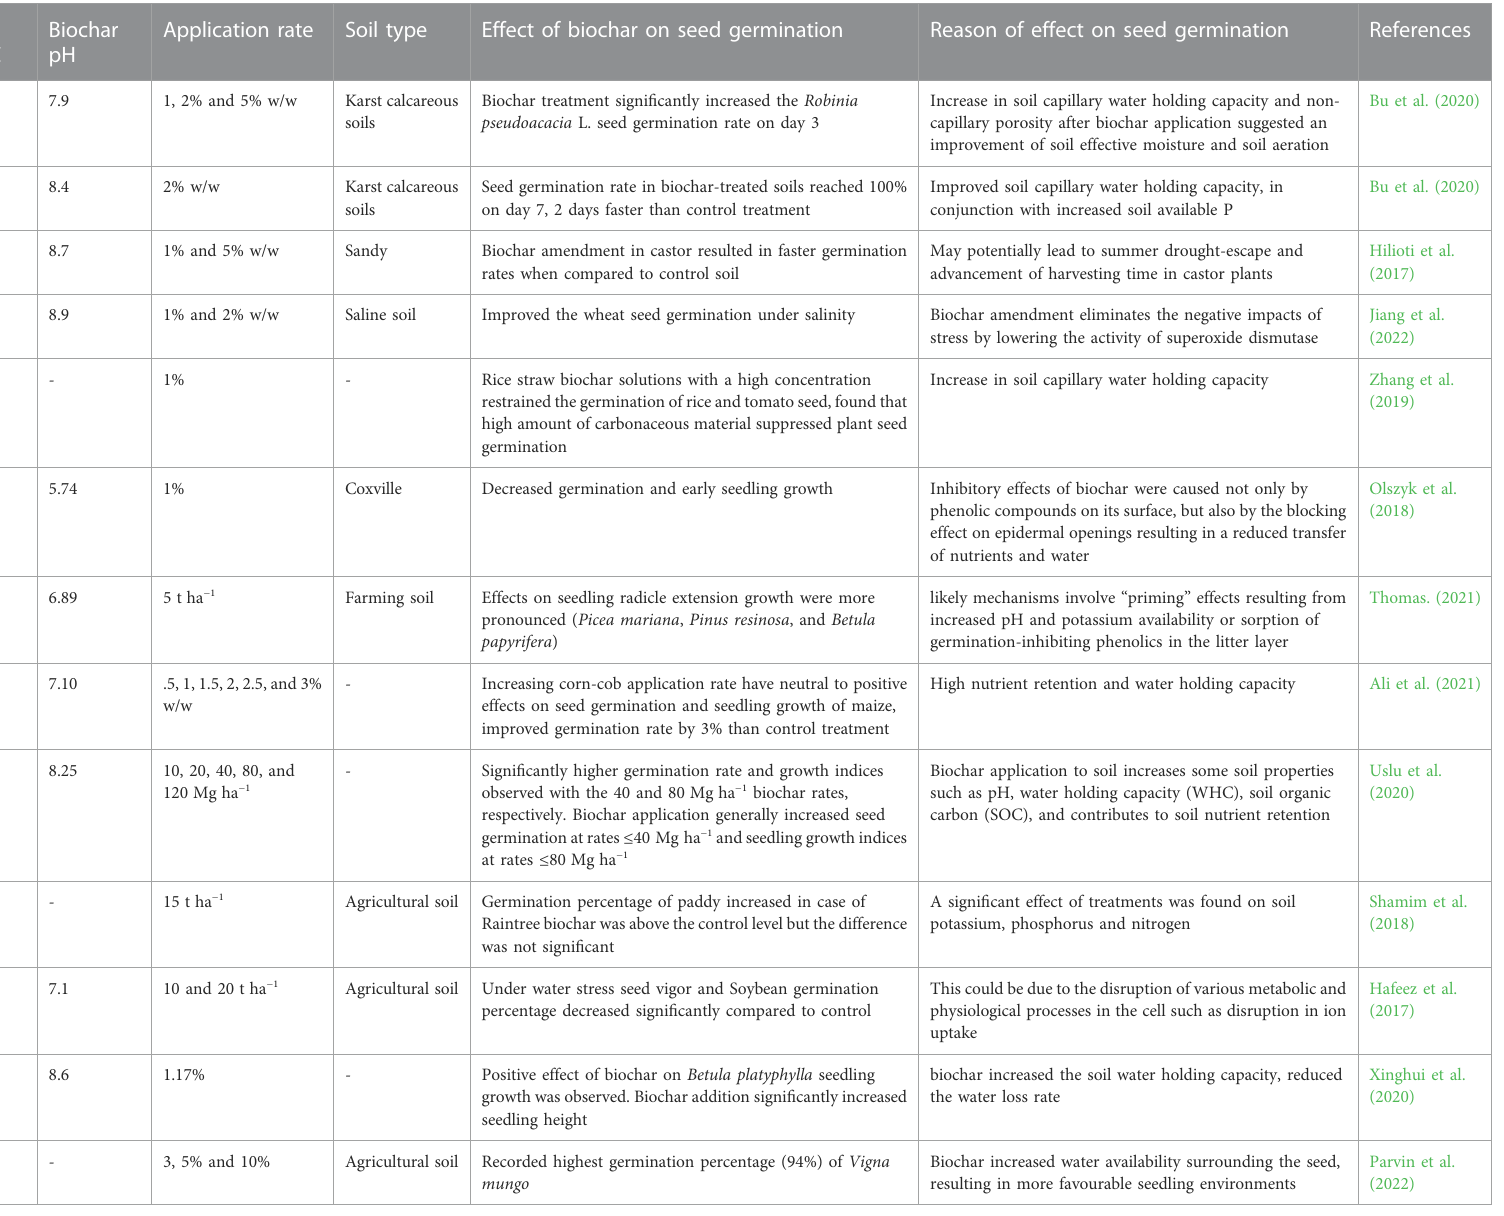
TABLE 5 Effect of biochar application on seed germination and seedling growth under different